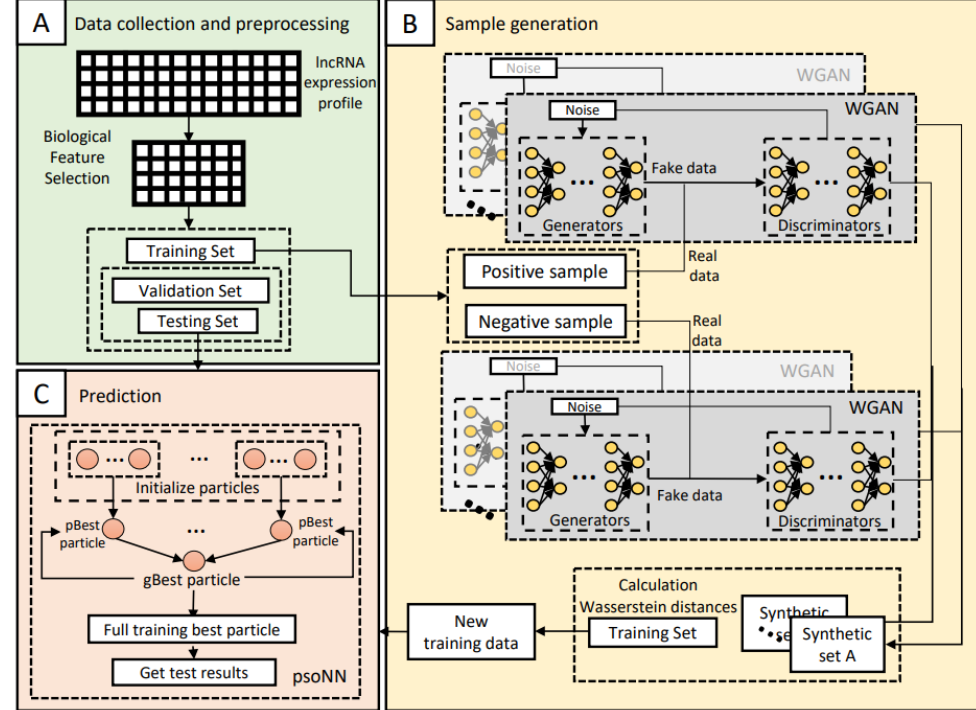
Figure 1. An overview of our proposed method for identifying the pan-cancer-related genes.Step 1: The original sample is pre-processed and then subjected to the biometric feature extraction method to reduce the dimensionality. Then it is divided into training set, validation set and test set. Step 2: The WGANs of different architectures are trained to generate synthetic data and the one with the smallest Wasserstein distance is selected as the new training set. Step 3: Use the psoNN model to predict tumor lymph node